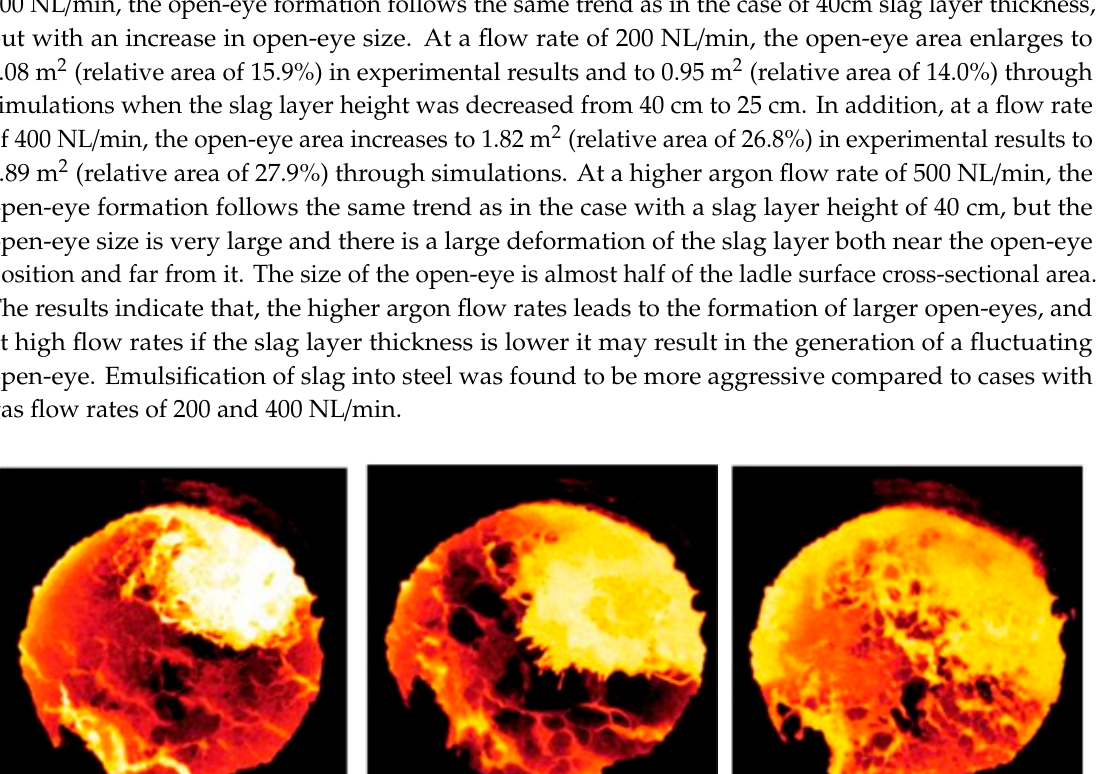
Figure 11. Open-eye size in the ladle from simulation results for a slag layer thickness of 55 cm: ( a ) Q = 200 NL/min, ( b ) Q = 400 NL/min, and ( c ) Q = 500 NL/min.